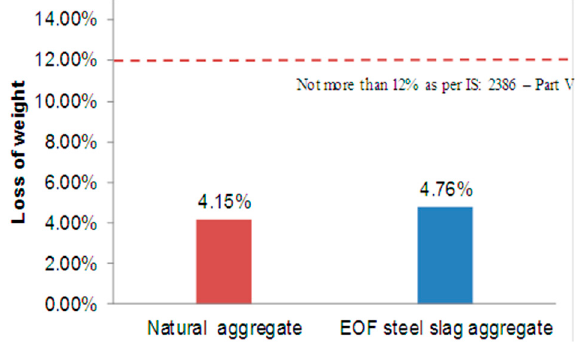
Figure 5. Percentage losses in soundness test.